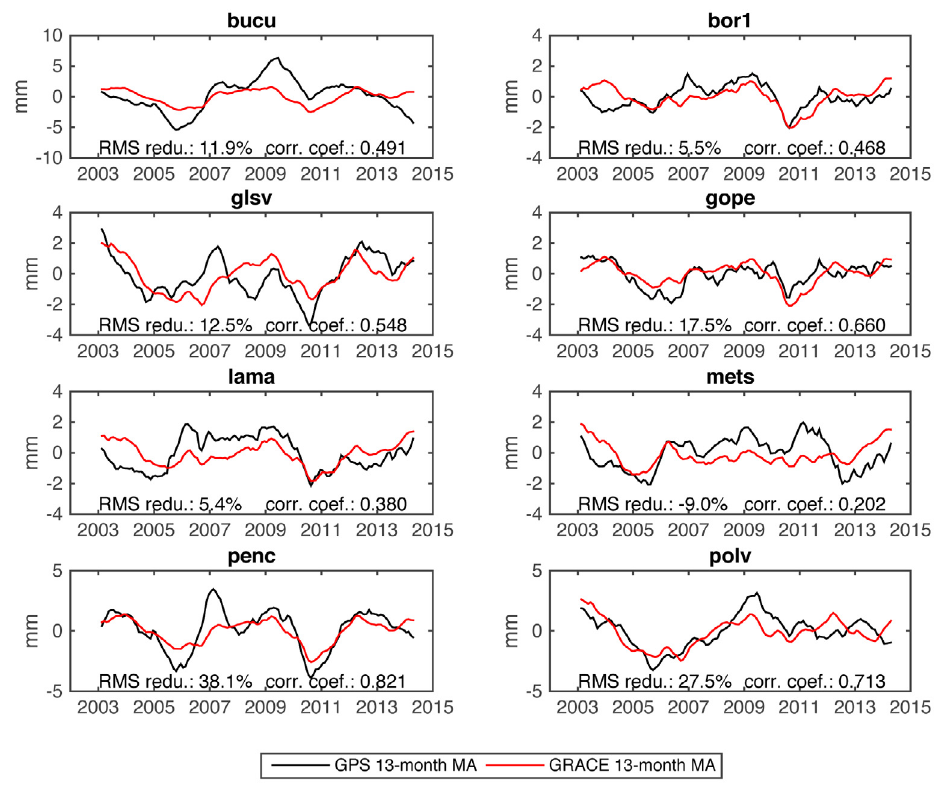
Figure 3. Comparisons of GPS height residuals and GRACE-derived vertical displacements after 13-month moving average filtering. WRMS reduction in GPS heights is computed after subtracting GRACE-derived displacements. Correlation coefficients are computed at zero phase